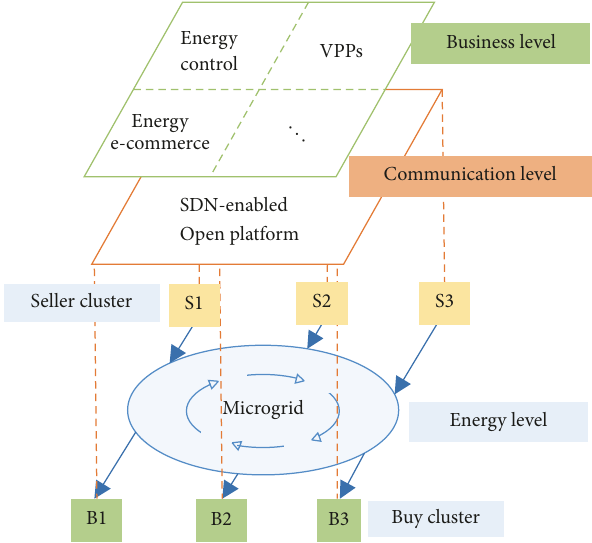
Figure 6: Multiple and flexible businesses based on SDN.